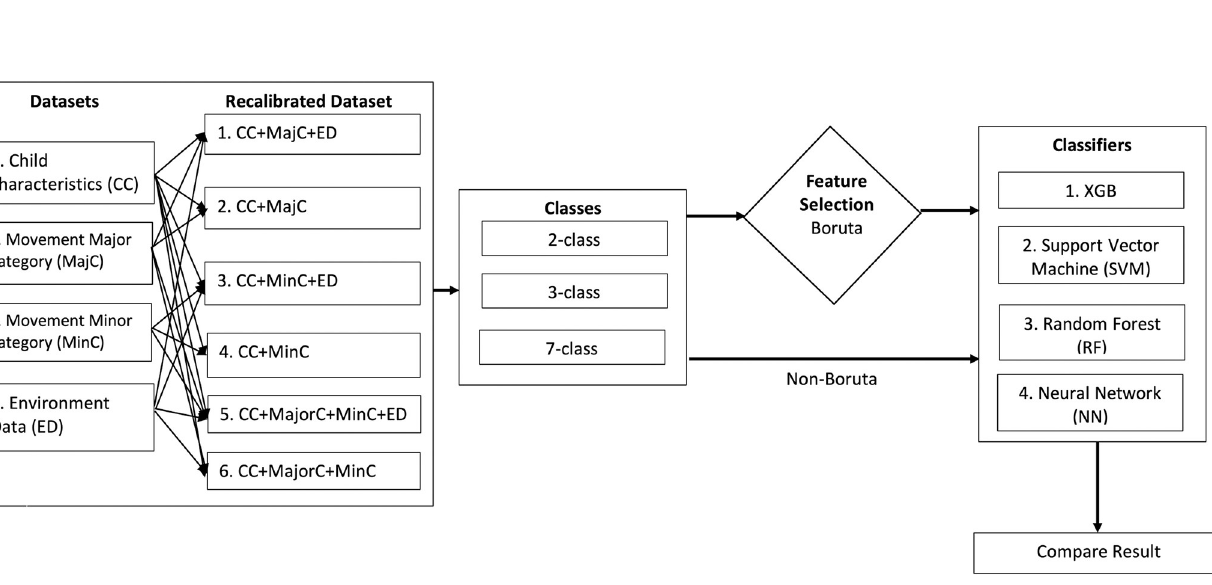
PLOS ONE | https://doi.org/10.1371/journal.pone.0269472 June 30,